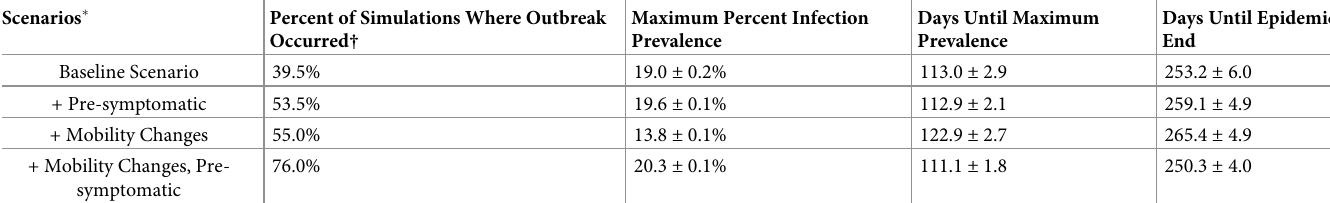
Table 3. Dengue virus predicted infection prevalence based on presence of pre-symptomatic period and/or disease-driven mobility reductions, presented as mean ± 2SEM. Scenarios